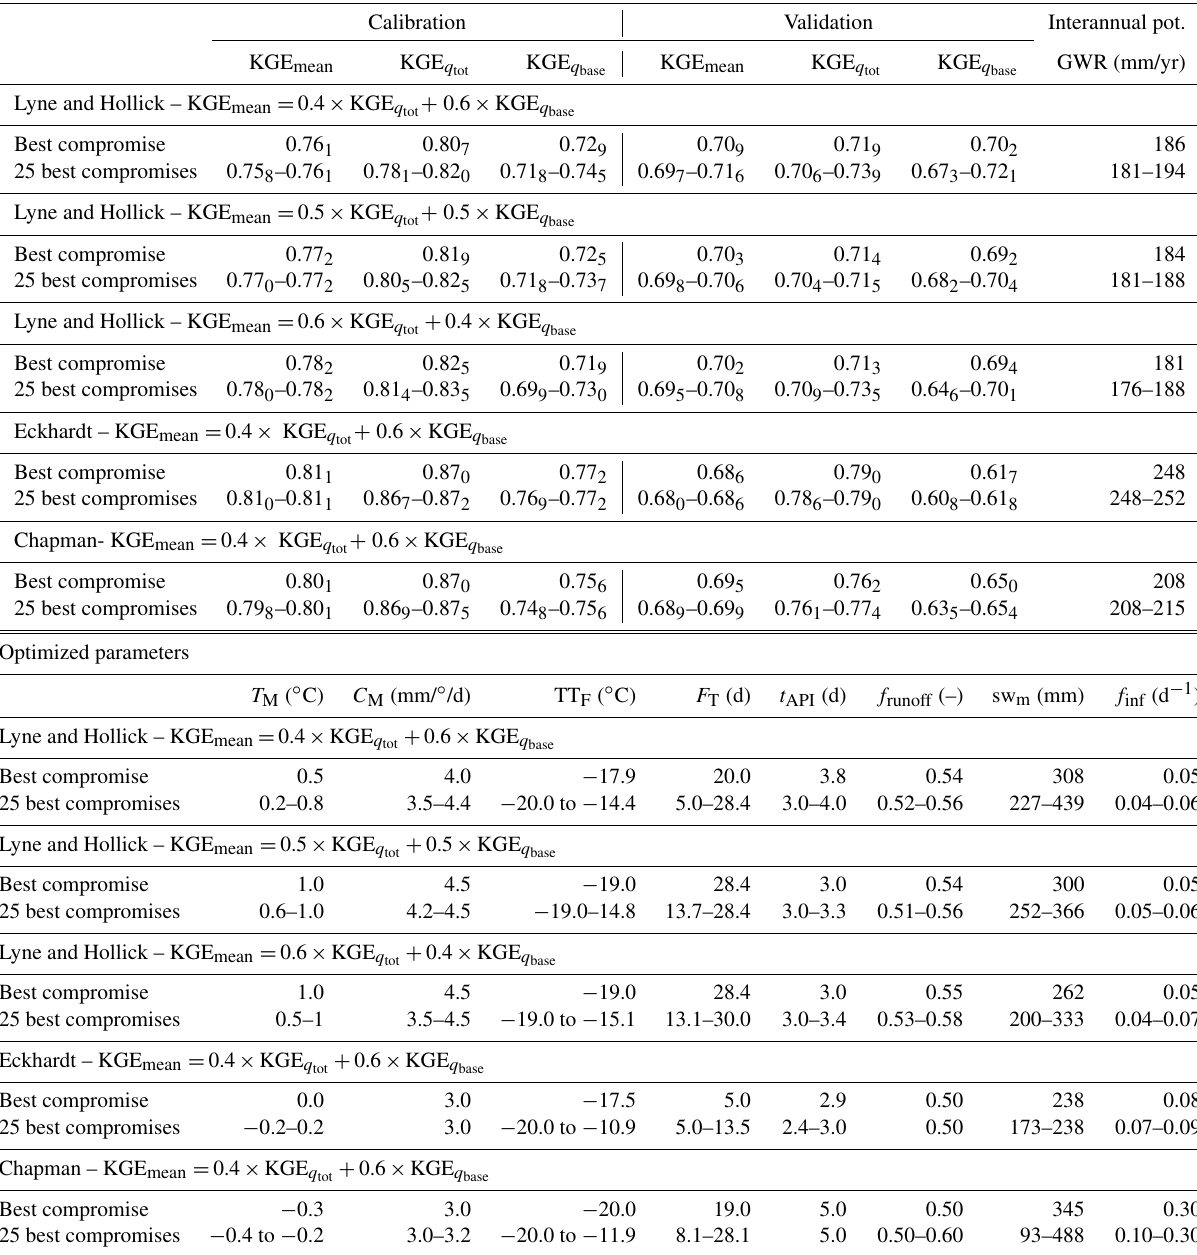
Table A1. Best compromises, interannual potential GWR, and optimized parameters obtained with the best compromises for the gauging stations of W6 and ranges obtained with the 25 best compromises (before regionalization) using different calibration weights and different baseflow separation